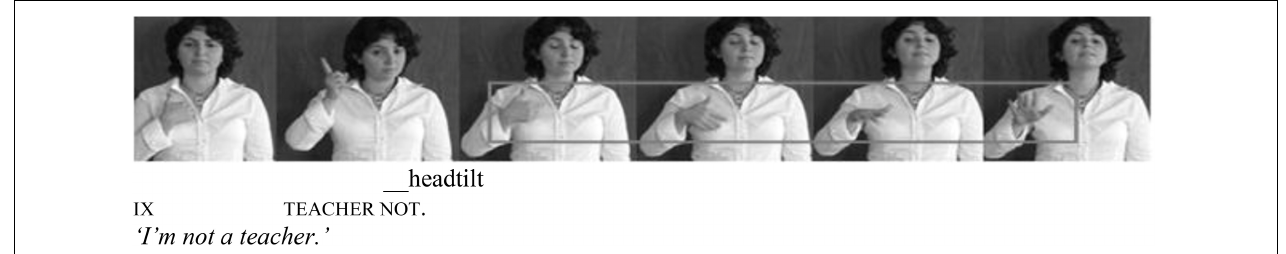
FIGURE 5 | Adapted with permission from Gökgöz